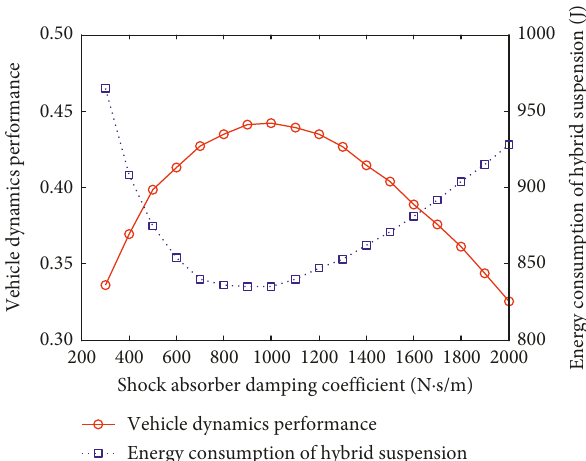
Figure 9: Relationship between the variable damping and the riding comfort, handling, and stability of vehicle at 30km/h speed.